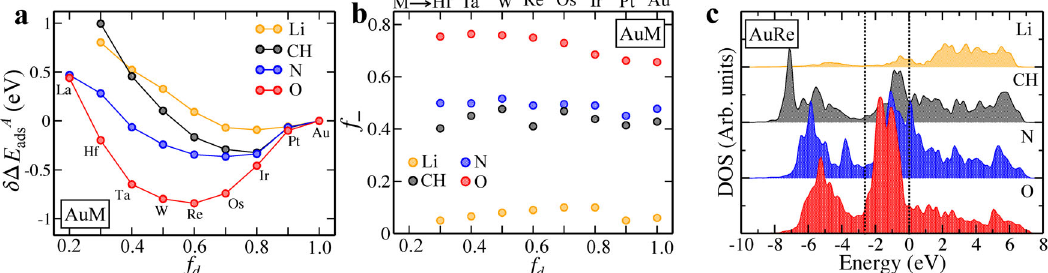
Fig. 6 Chemisorption as a function of f d . a The DFT calculated adsorption energy of O, N, CH, and Li as a function of f d on Au NSAs having 5 d metals in the second layer. All energies are relative to pure Au. b The fi lling factor ( f − ) of antibonding states of the adsorbates as function of f d . c The pDOS is shown for O, N, CH, and Li adsorbed on the AuRe NSA. The region enclosed by the dotted box identifying the fi lled antibonding states serves as a guide to the